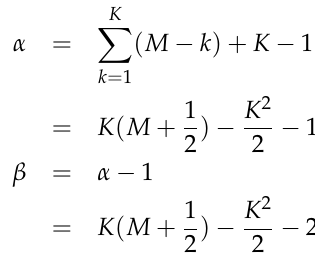
Figure 9. Performance of new residual frequency estimation method ( ∆ f M = 20). ( a ) mean errors of estimations; ( b ) zoomed view of ( a ); ( c ) standard deviation of